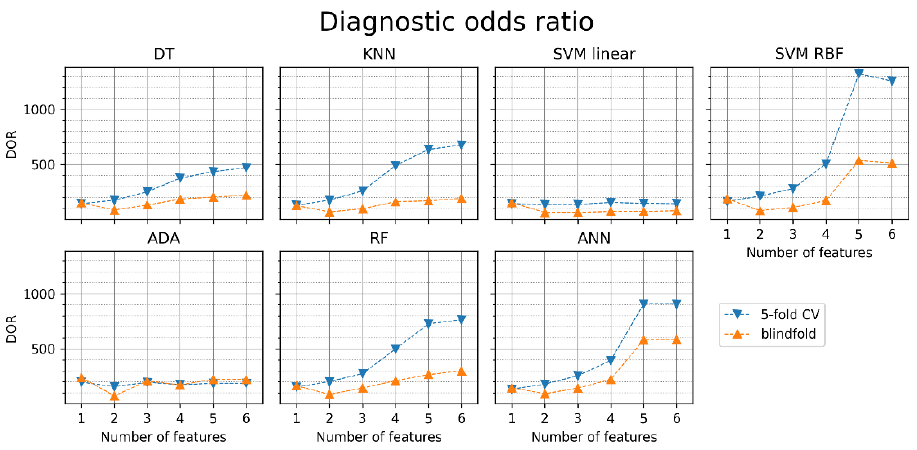
Figure 12. Diagnostic odds ratio (DOR) of atrial fibrillation detection for different classifiers with sets of one to six features (orange points — blindfold validation, blue points — 5-fold cross-validation). DT — decision tree, KNN — K nearest neighbors, SVM linear — support vector machine with linear kernel, SVM RBF — support vector machine with radial basis function kernel, ADA — Ada Boost, RF — random forest, ANN — artificial neural network.